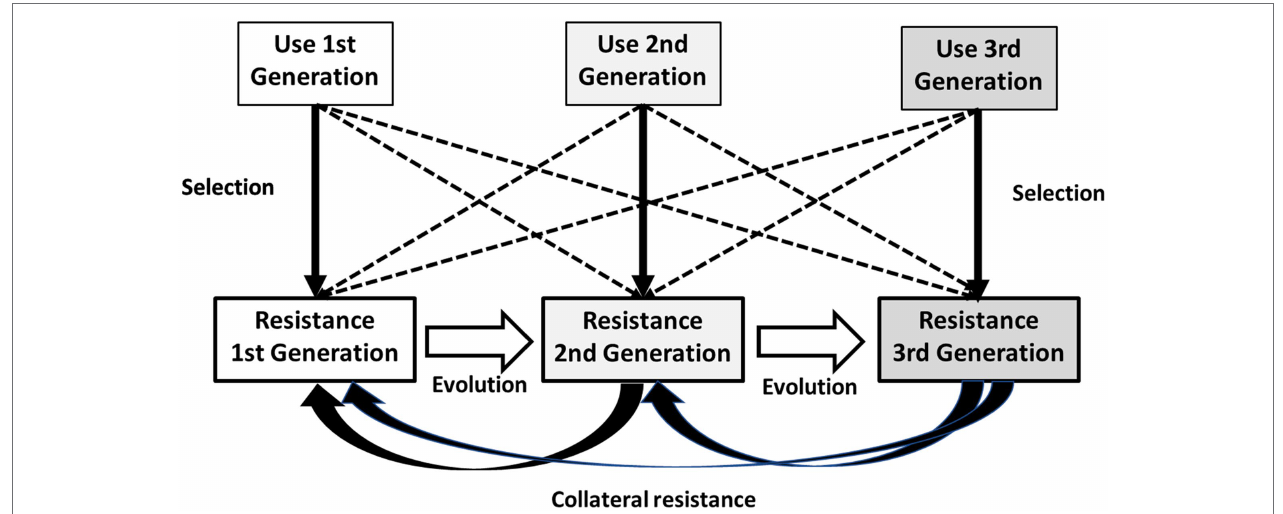
FIGURE 2 | Key role of first-generation antibiotics within a family of drugs in maintaining and extending antibiotic resistance. Each generation of drugs preferentially selects resistance to the corresponding generation (vertical thick arrows) but might select for resistance to other generations (broken arrows). Quantitative expansion of resistance to first-generation drugs provides a wealth of genetic sequences from which evolution to resistance to second- and third generation drugs takes place (white horizontal arrows). Resistance to second- and third-generation antibiotics frequently inactivates (and then selects by collateral resistance, curved arrows) resistance to first-generation drugs, which is amplified by the constant use of all members of the family and is thus maintained as a growing source of variation and selection of resistance to the whole